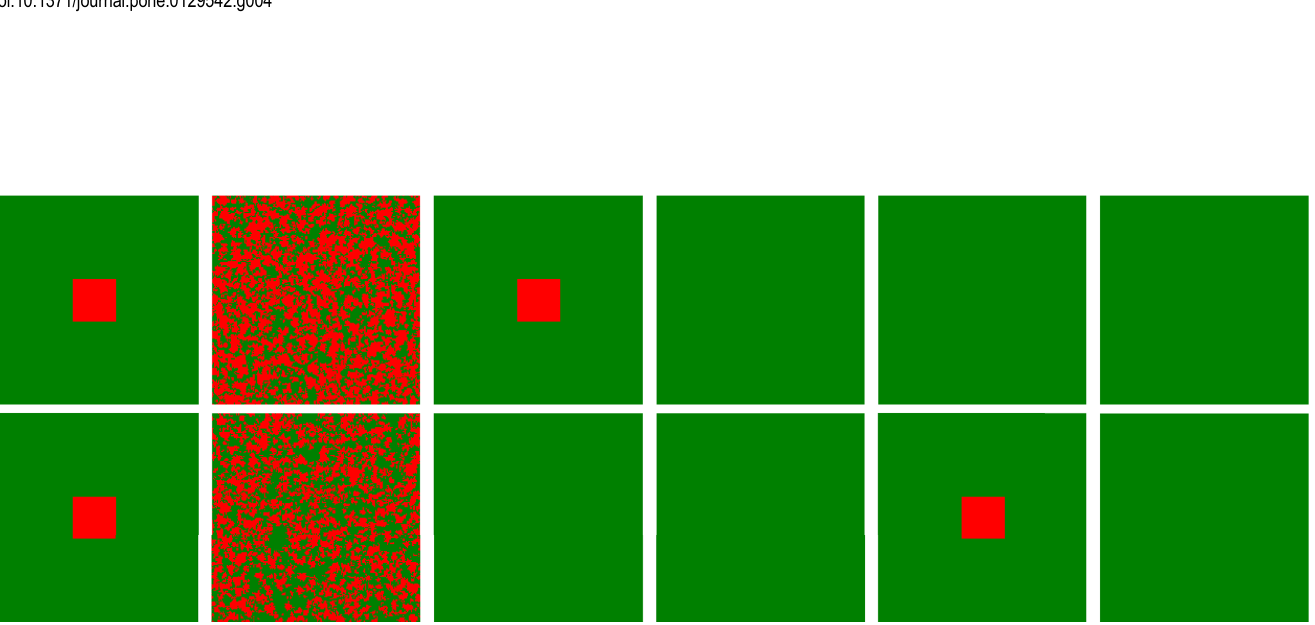
Fig 5. For a specific initial setup, the characteristic patterns between cooperators and defectors on two interdependent lattices at MCS = 1 and MCS = 50000 under case II. In all panels, red dots represent cooperators and green dot denote defectors. For the left four panels, central cooperators are initially set on upper and lower lattices at the same time; only cooperators exist on the center of upper lattices in the middle four panels; while only cooperators exist on the center of lower lattices in the right four panels. Here, the coupling strength for each player is independently assigned from Eq (2). Likewise, the coupling of C-C type setup facilitate the evolution of cooperation on interdependent networks, and only that the fraction of cooperators is slightly less than that under the case I . The simulation parameters are still set to be: MCS = 50000, b = 1.05, L = 200, K = 0.1 and A =